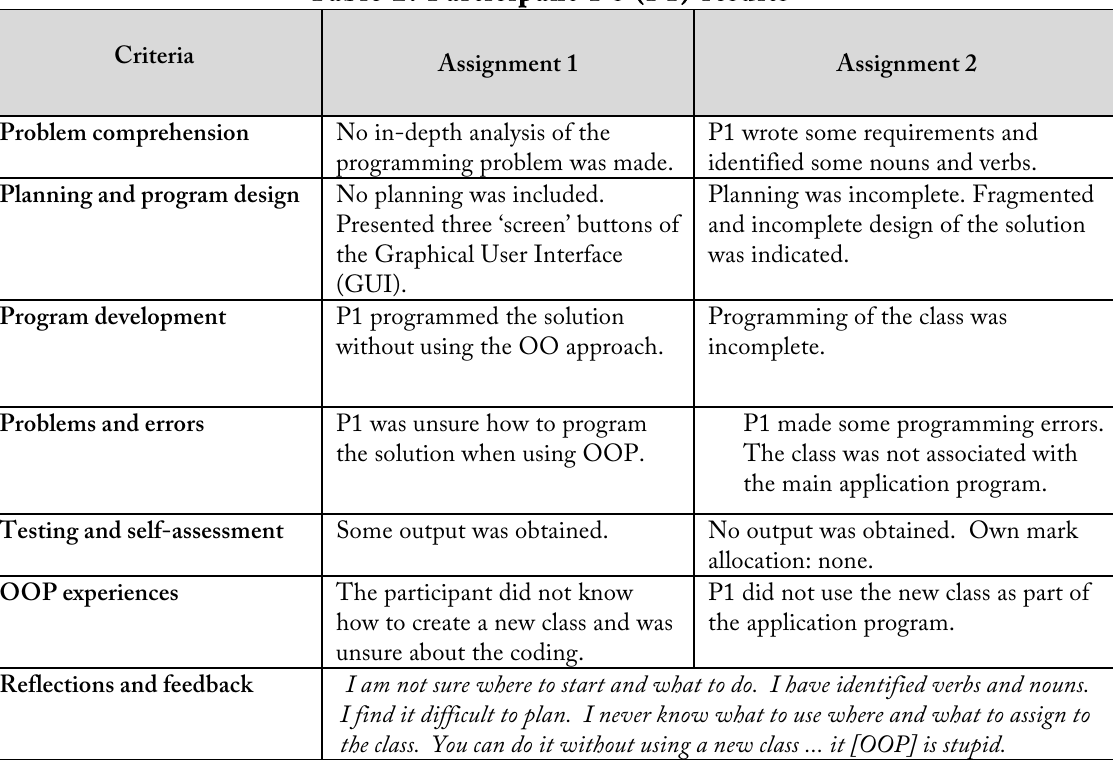
Table 2: Participant 1’s (P1) results